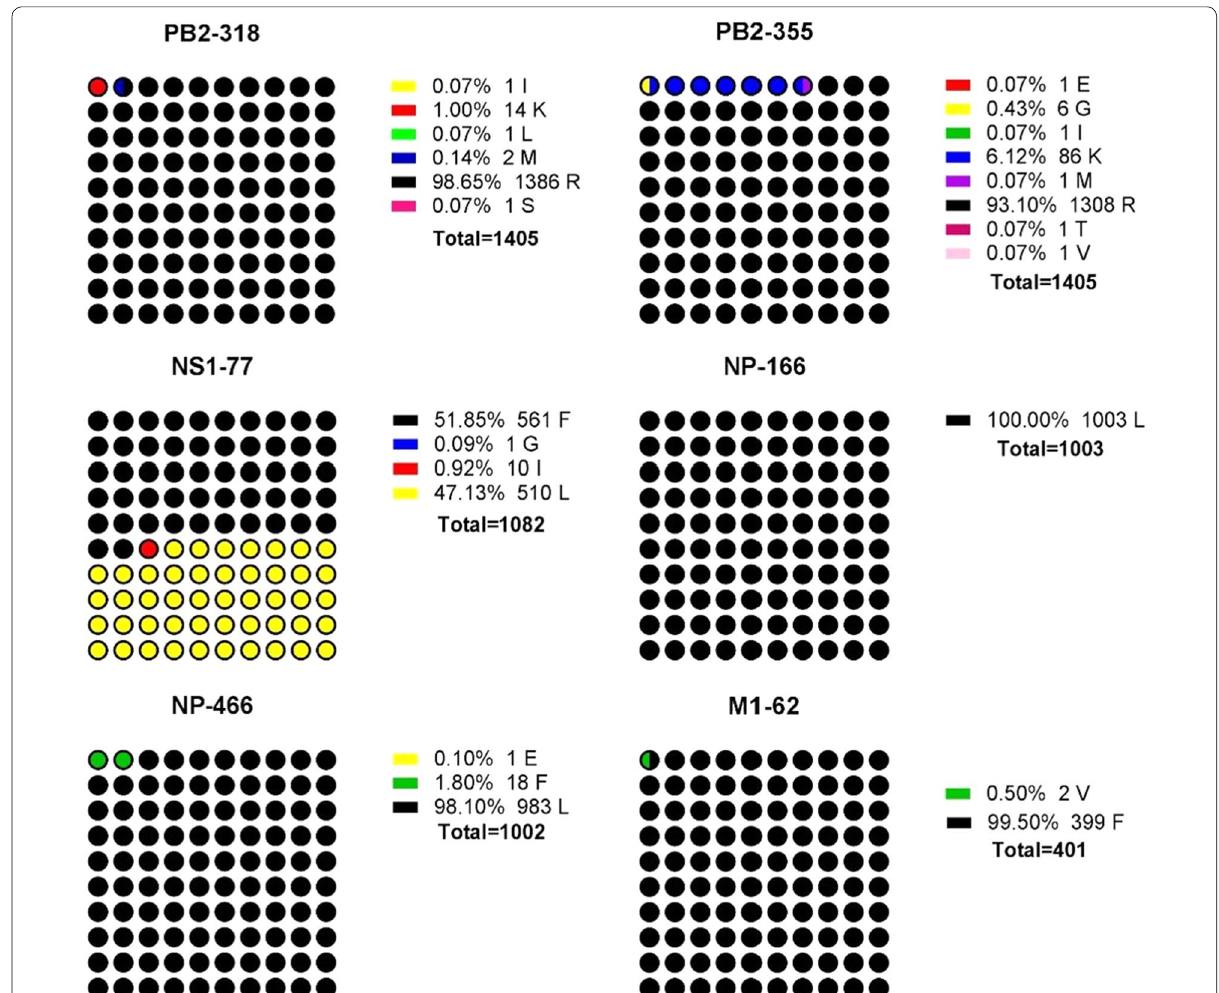
Fig. 6 Mutation rate of wild-type strains in NCBI. The genes were loaded from